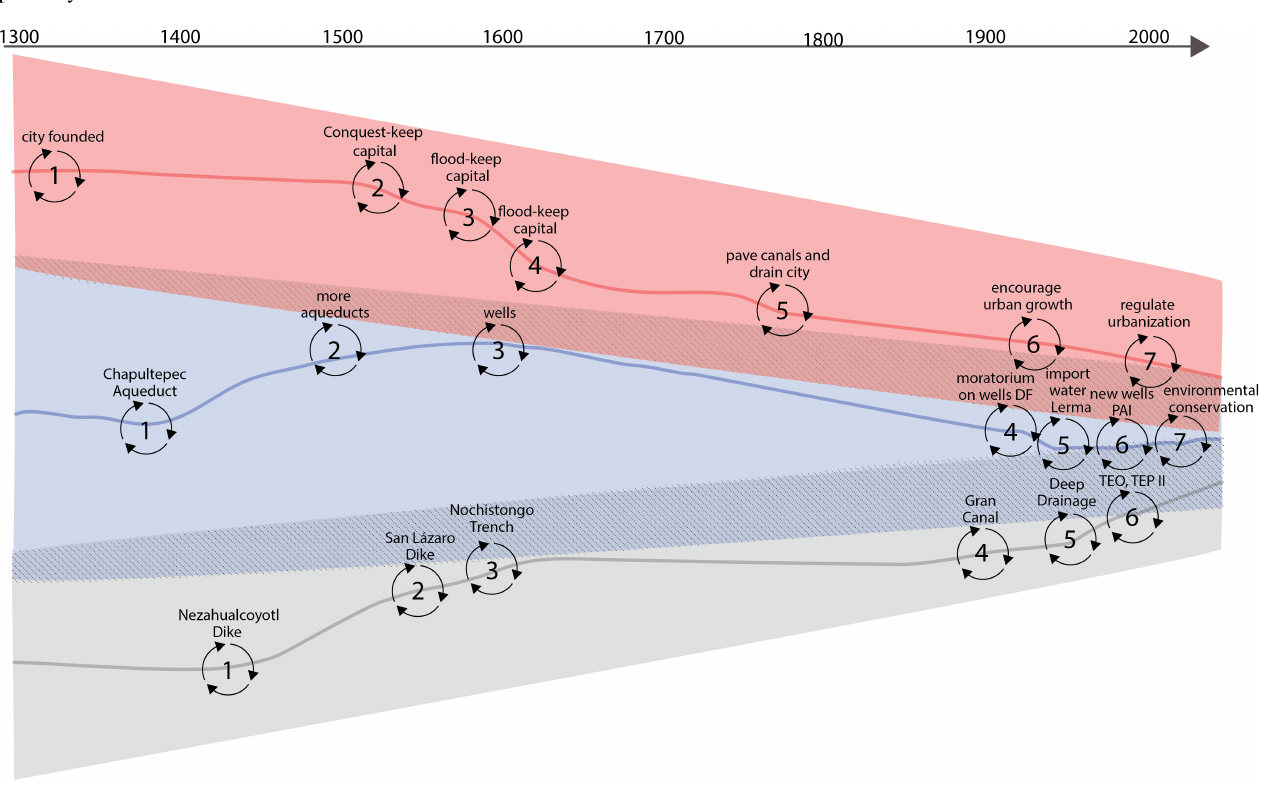
Fig. 5 . Timeline of three interacting adaptation pathways for Mexico City: human settlement (red), flood risk (gray), and water supply (blue). Major decision cycles for each pathway are outlined, and they overlap over time (see shaded/hatched areas). We conceive of the width of shading in each pathway as its adaptation space. This space has narrowed over time with efforts of city managers to increase system robustness. As a result, the system risks becoming maladaptive as it moves toward the boundary of the adaptive space, with less flexibility in responding to stress. The adaptation space for each pathway overlaps over time, as increasing system complexity, feedbacks, and connectivity ensure that decision cycles for one pathway influence the adaptive space in other